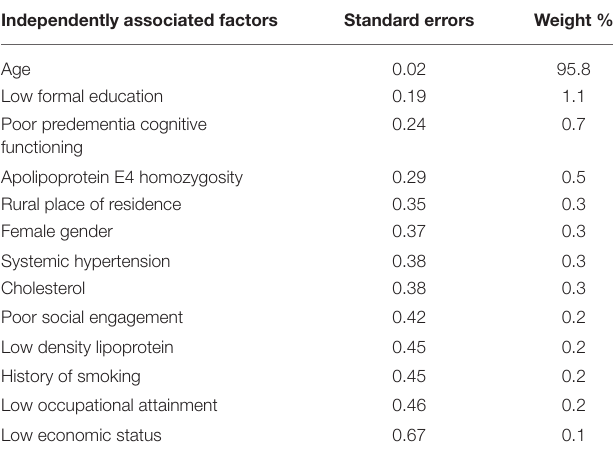
TABLE 2 | Independent risk factors for incident dementia in Sub-Saharan Africa (ranked by the inverse of variance method). Independently associated factors Standard errors Weight % Age 0.02